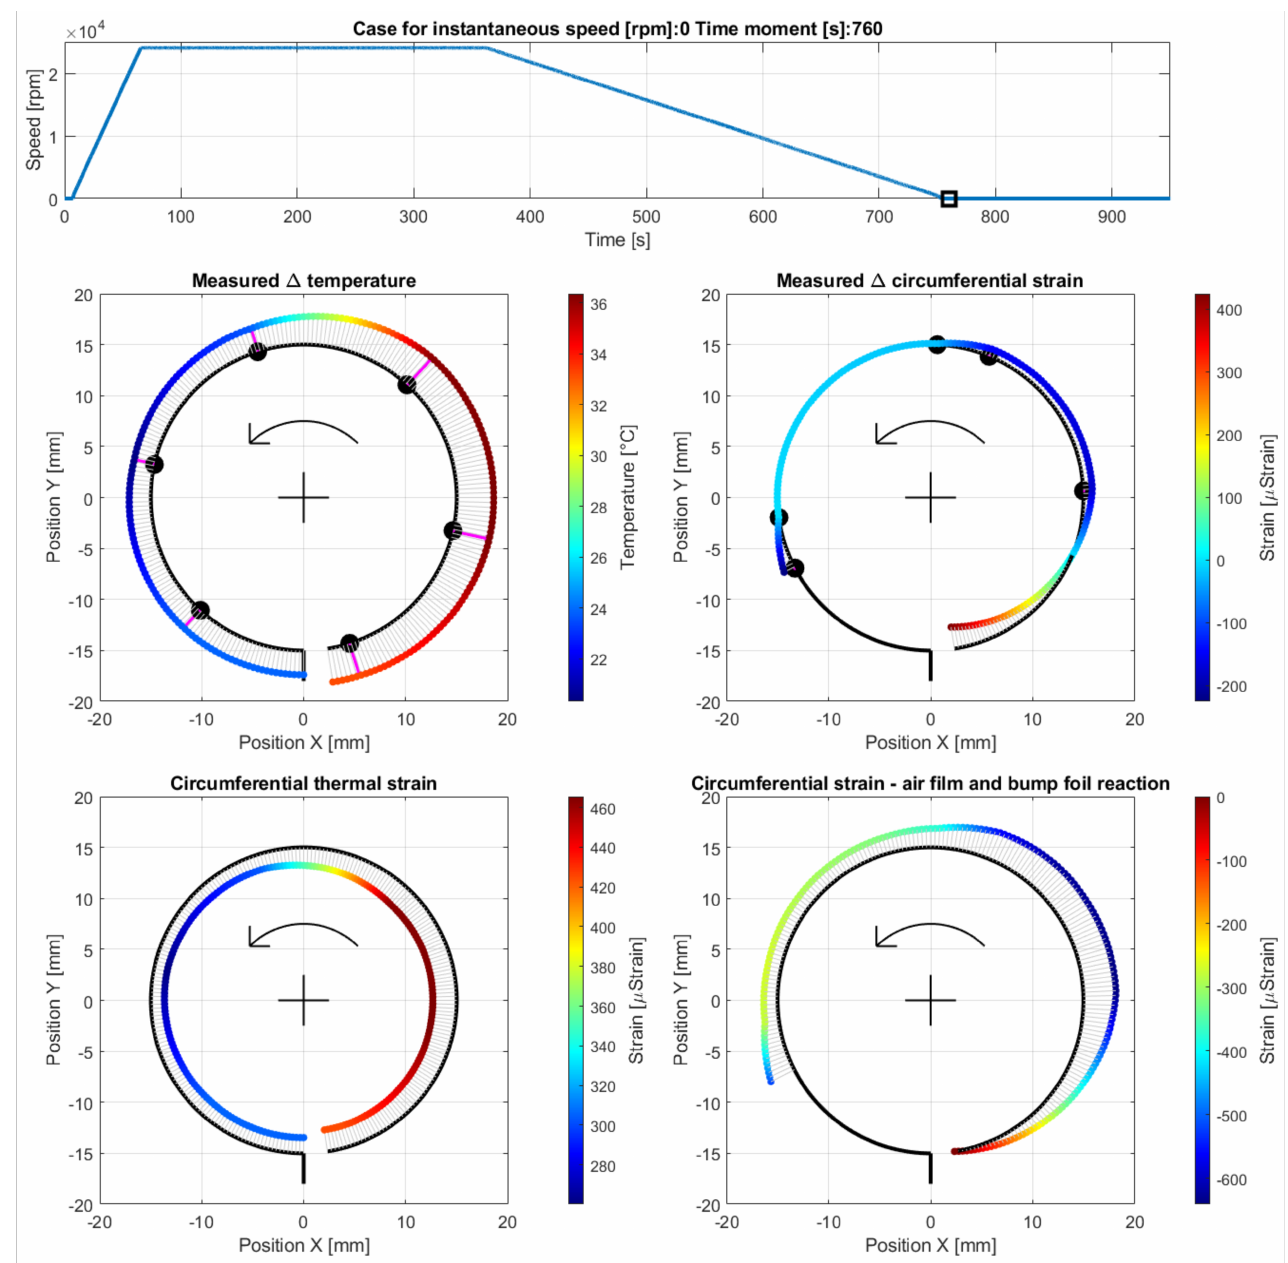
Figure 17. Cross-sectional views for the circumferential distribution of temperature and strain identified in the top foil at the stopped shaft. The curves used to visualize the strains are rescaled by the factor 0.5 compared to Cases A to